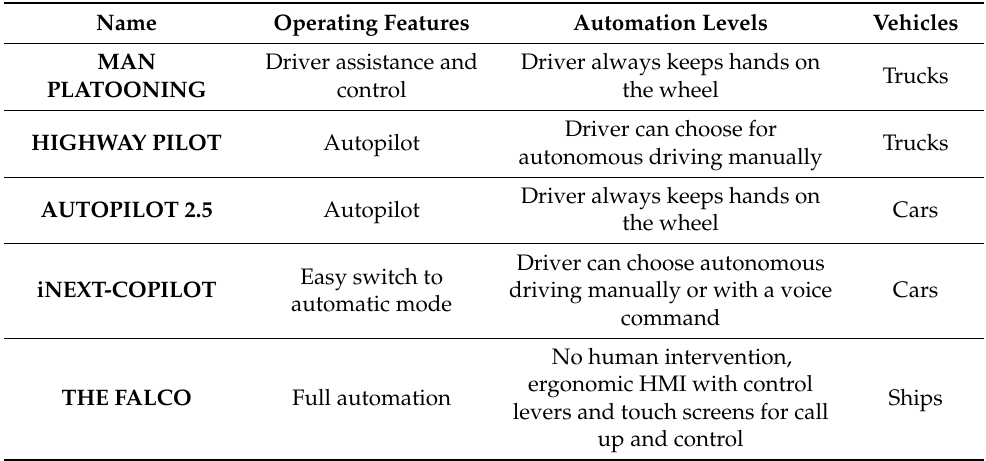
Table 2. Overview of investigated systems implemented in vehicles outside the railway sector.